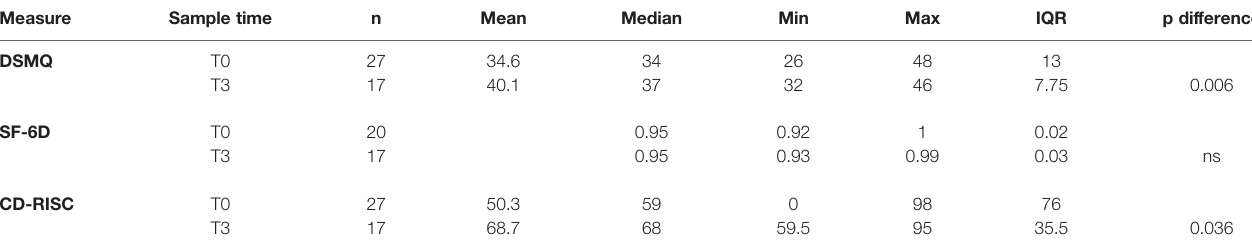
TABLE 3 | Quality of life outcomes.